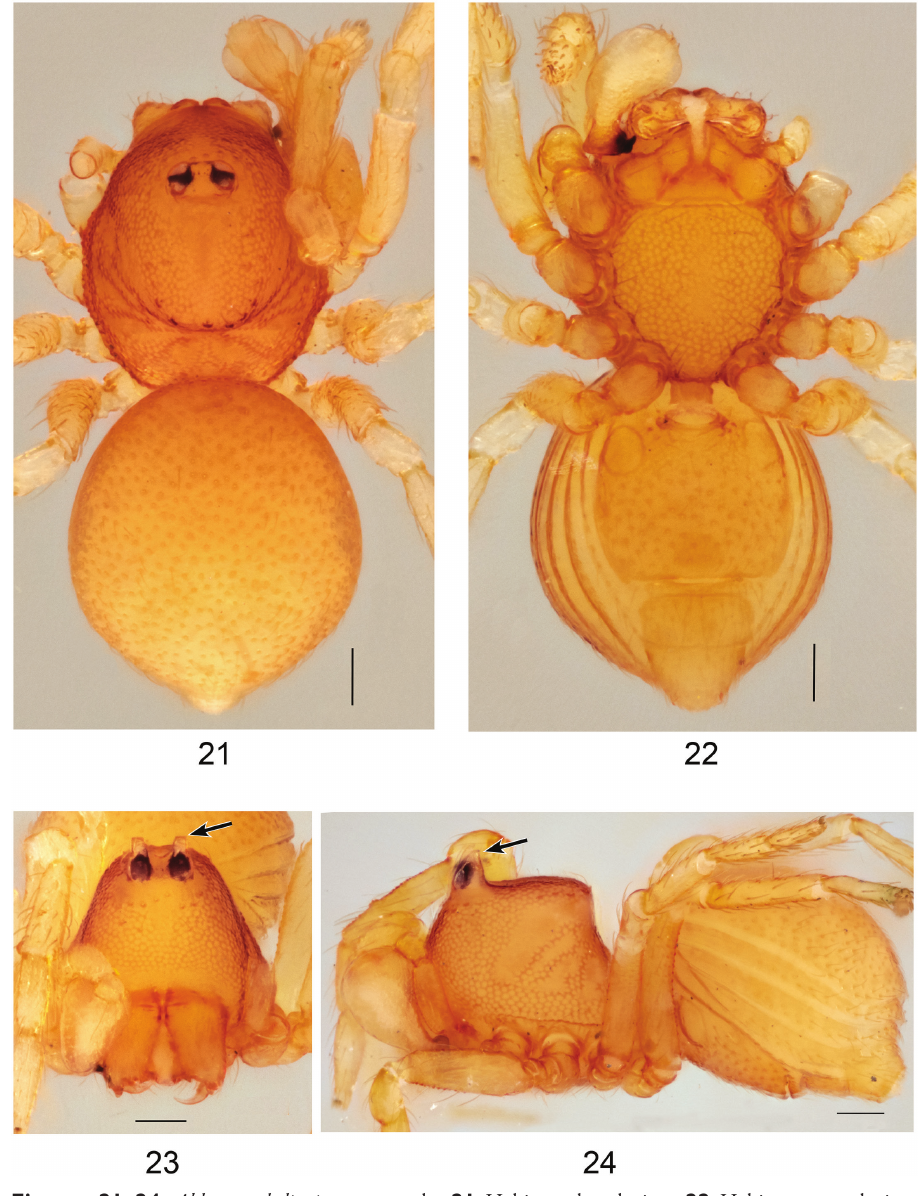
Description. Male (holotype) . Measurements: Total length: 1.06; carapace len- gth: 0.47; carapace width: 0.42; abdomen length: 0.59; abdomen width:0.51; clypeus height: 0.22. Length of legs: I 1.14 (0.38, 0.12, 0.29, 0.15, 0.20); II 1.02 (0.30,